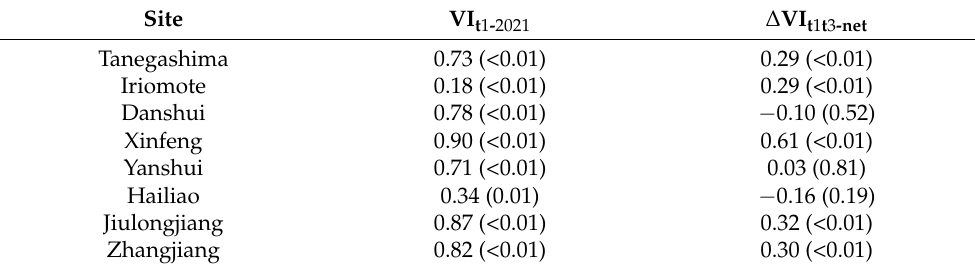
difference infrared index (NDII) before the cold wave of 2021 (t1) and for their net change between 30 days after the end of the 2021 cold wave (t3) and pre- and the post-cold wave values in the eight East Asian mangrove sites. p -values are indicated in parentheses next to Spearman’s ρ